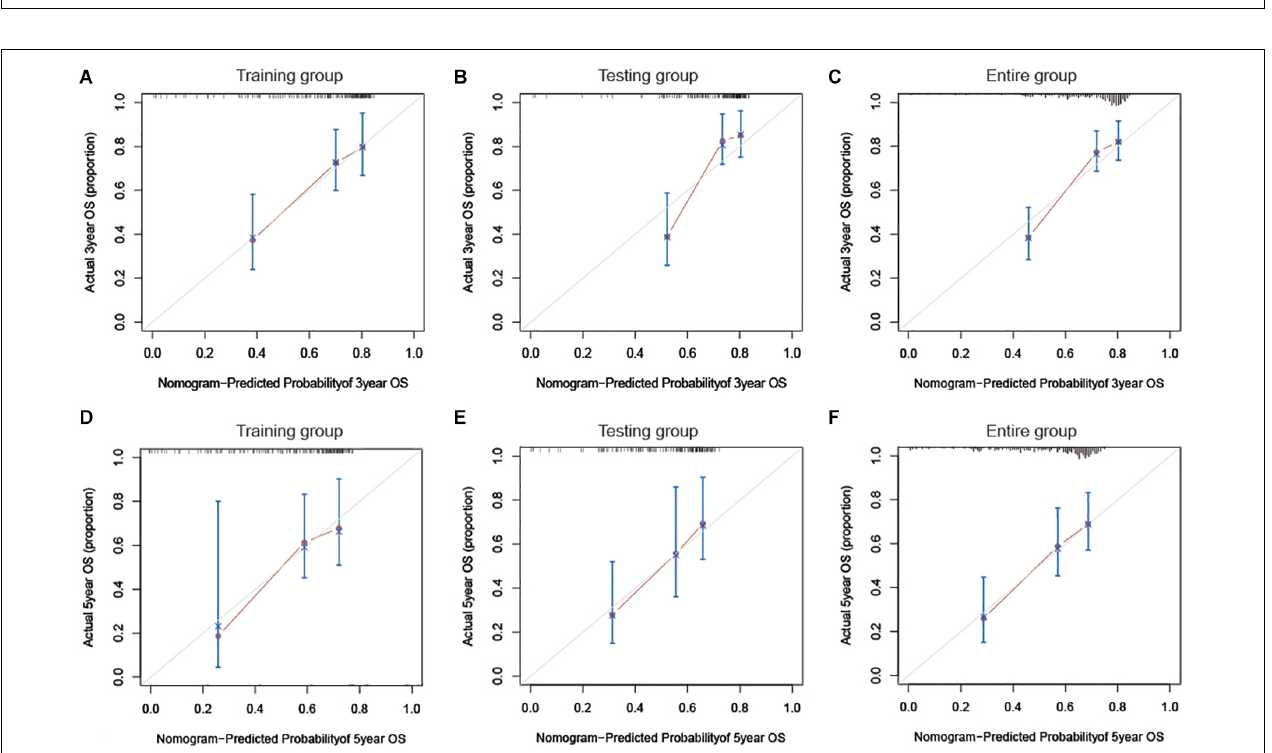
FIGURE 8 | A 3-and 5-year calibration curve of OS in the training group (A,D) , testing group (B,E) , and the entire group (C,F) . OS, Overall survival.